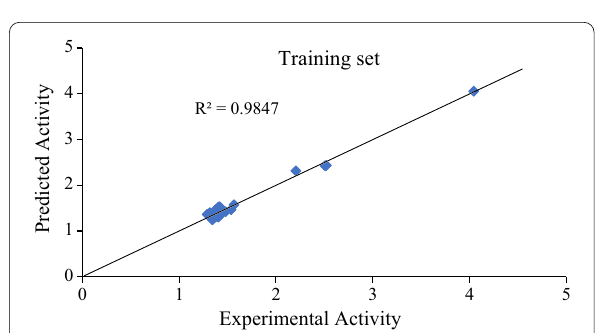
Fig. 1 Plot of experimental activity against predicted activity of the training